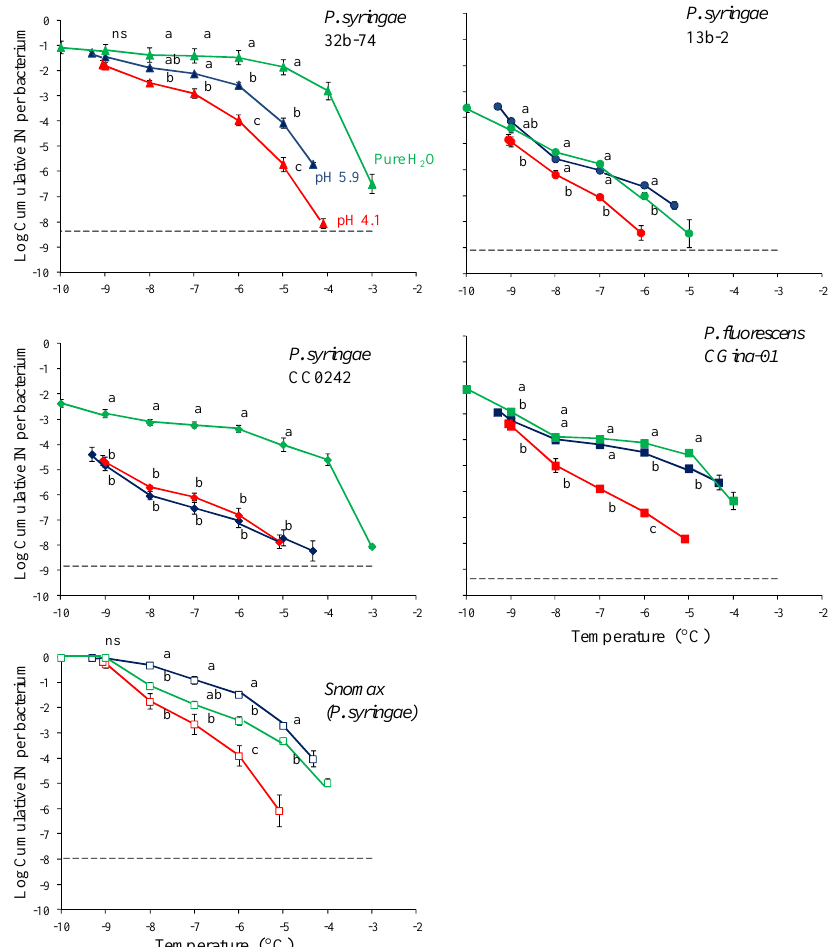
Fig. 2. Ice nucleation spectra of Pseudomonas strains submitted to different pH: pH = 4.1 (red), pH = 5.9 (blue) and in distilled water as a control (green). Data were corrected for water activity of the buffer and linearly interpolated. The horizontal line corresponds to the lower limit of detectable activity depending on the initial bacterial concentration of each experiment. Symbols are as in Fig. 1. At each temperature, values associated with different letters are significantly different ( p < 0.05) based on Tukey’s test. ns: no significant treatment effect. Errors bars indicate standard errors ( n = 4).